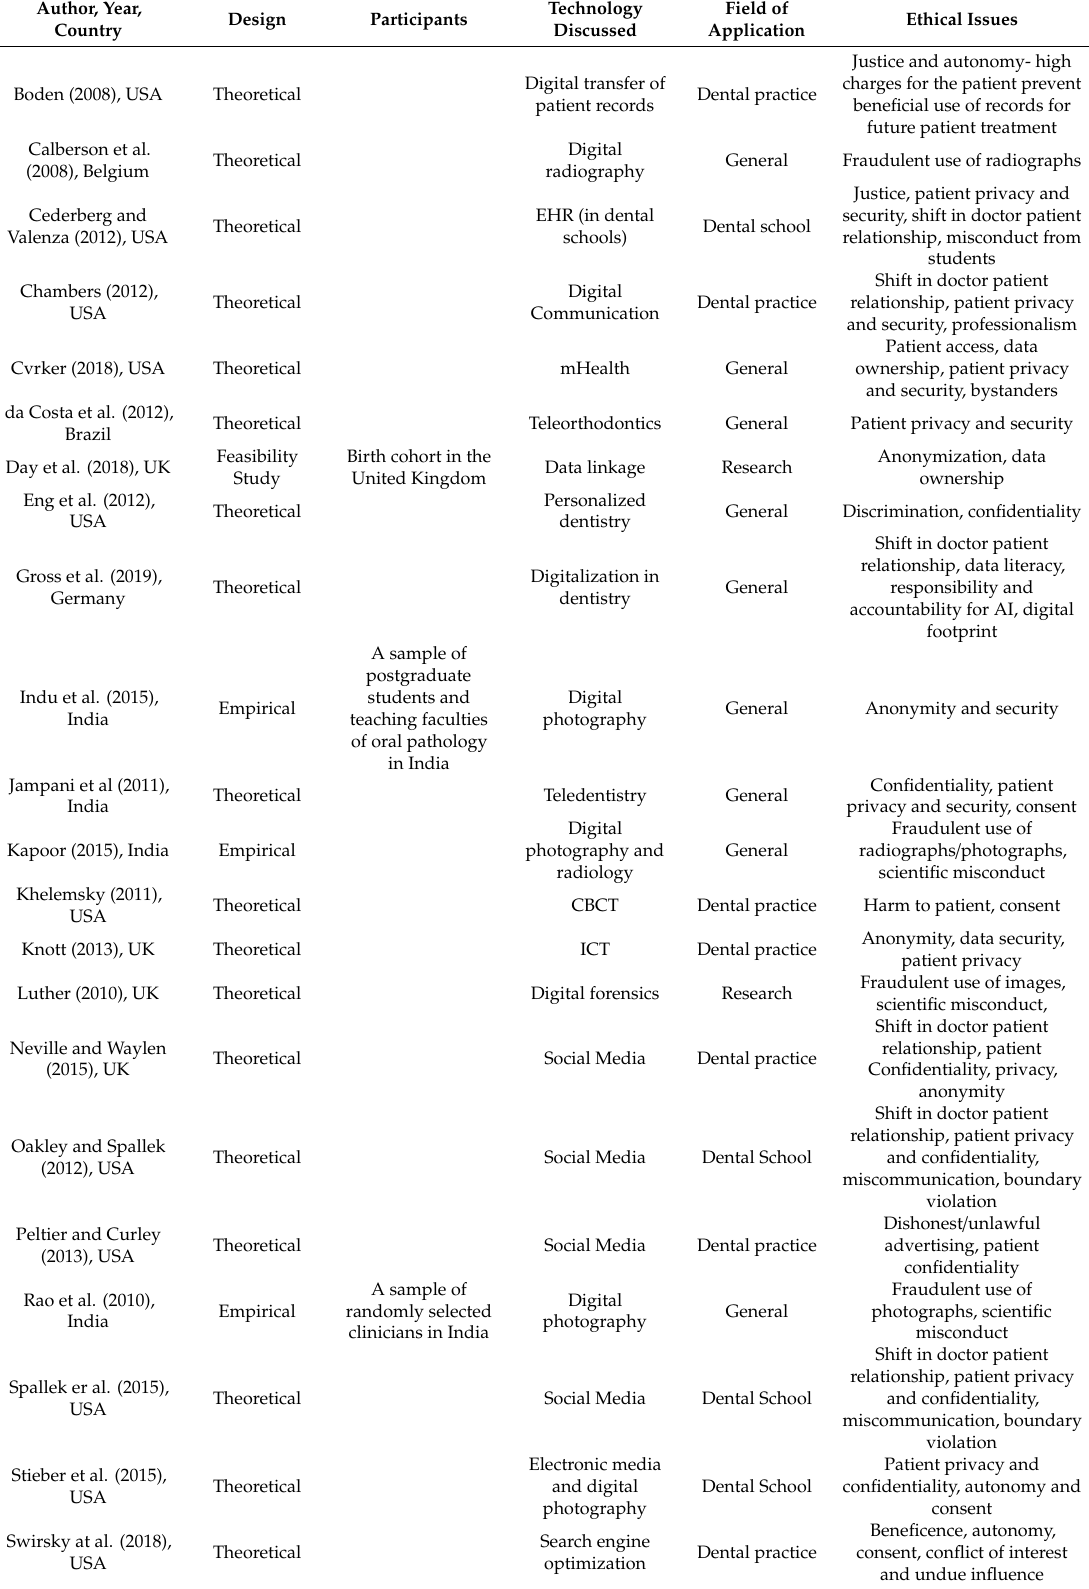
Table 2. Retrieved papers. EHR, electronic health record; mHealth, mobile health; CBCT, con-beam computed tomography; ICT, internet and communication